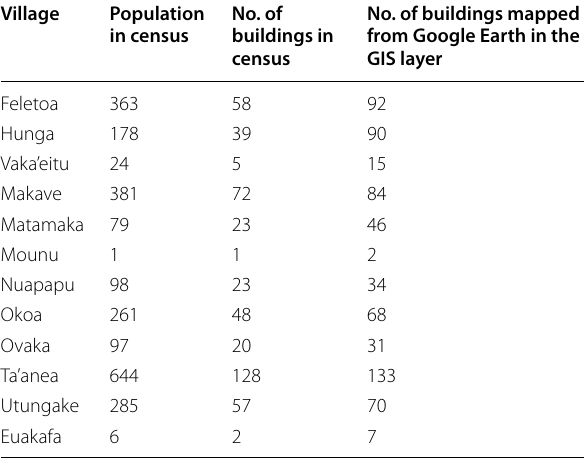
Table 1 Update of the GIS layer of buildings for 11 villages using Google Earth